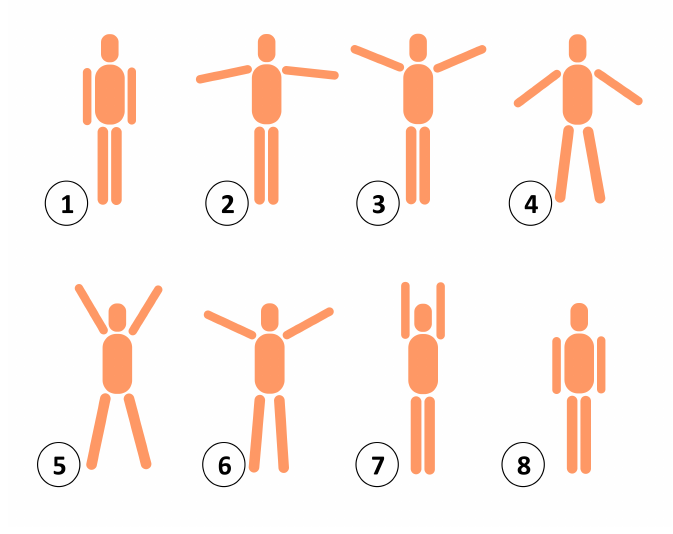
Figure 5. Sequence of movements in anthroposophic